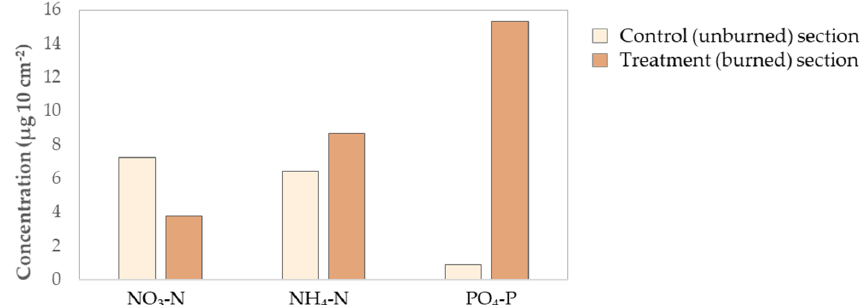
Figure 3. Concentrations of nitrate, ammonia, and phosphate over the burial between 10 July and 10 August 2019 based on Plant Root Simulator (PRS ® ) probe data. The reported results represent pooled measurements for the burned and unburned sections.